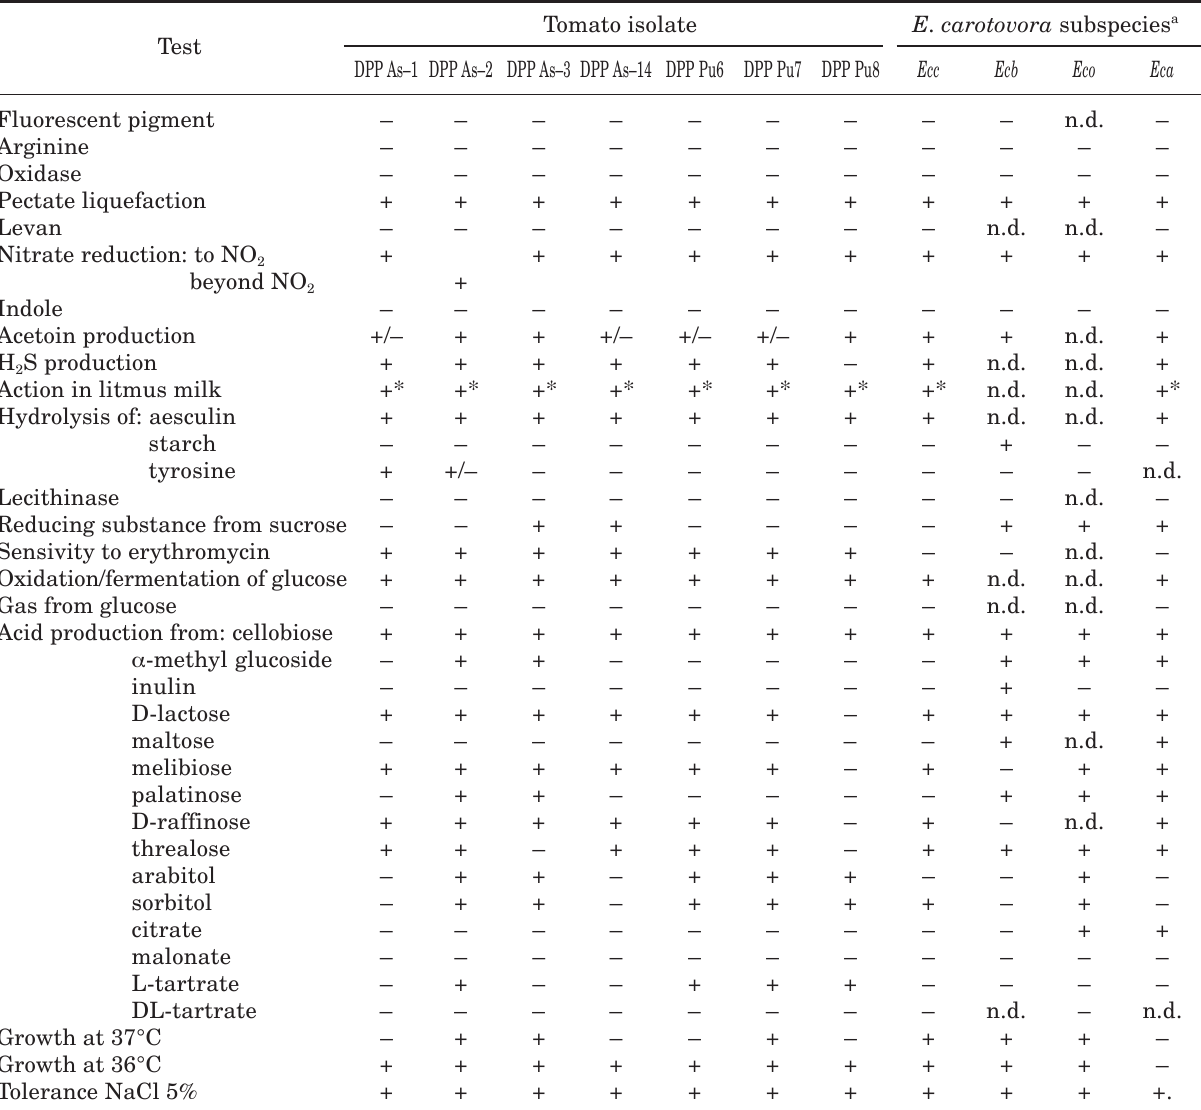
Table 2. Biochemical and physiological characteristics of tomato isolates compared with E. carotovora